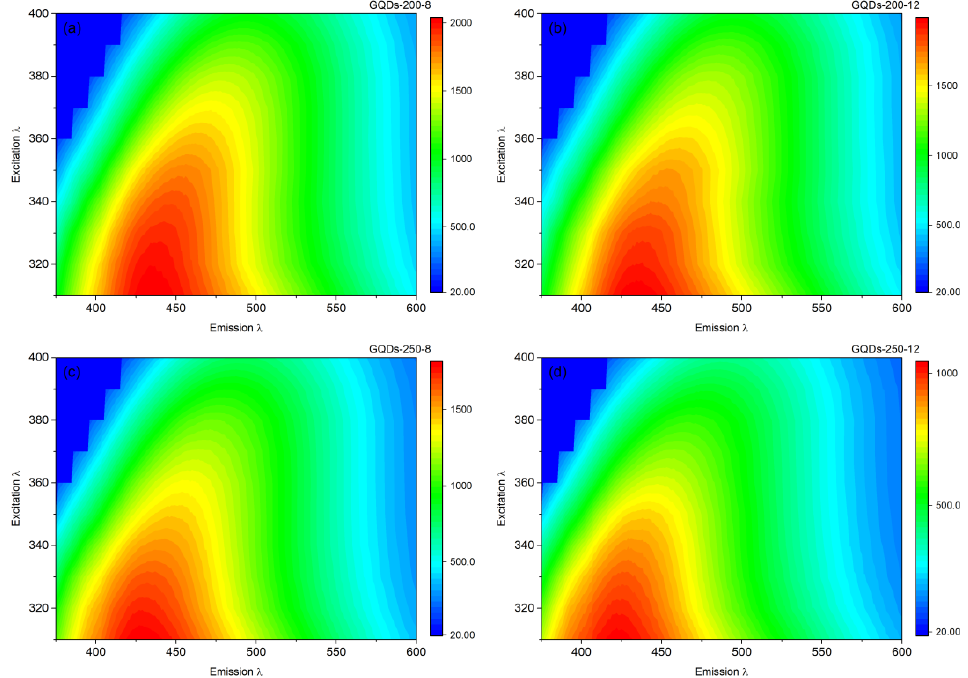
Figure 4. Contour maps of ( a ) GQDs-200-8, ( b ) GQDs-200-12, ( c ) GQDs-250-8 and ( d ) GQDs-250-12 for photoluminescence emission at a range of excitations from 310 to 400 nm.